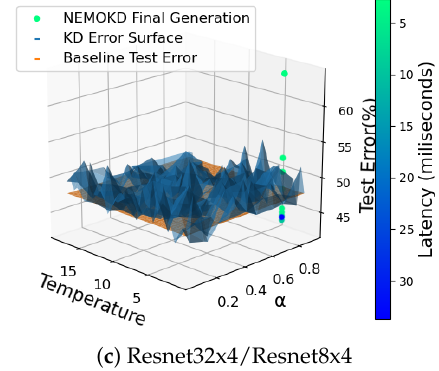
Figure 9. Knowledge distillation parameter search for Teacher/Student distillation For the MobileNetV2 teacher, a FlexStudent student model and CIFAR10 in Figure 9a, any choice of knowledge distillation hyper-parameters provided a significant increase in accuracy over the baseline